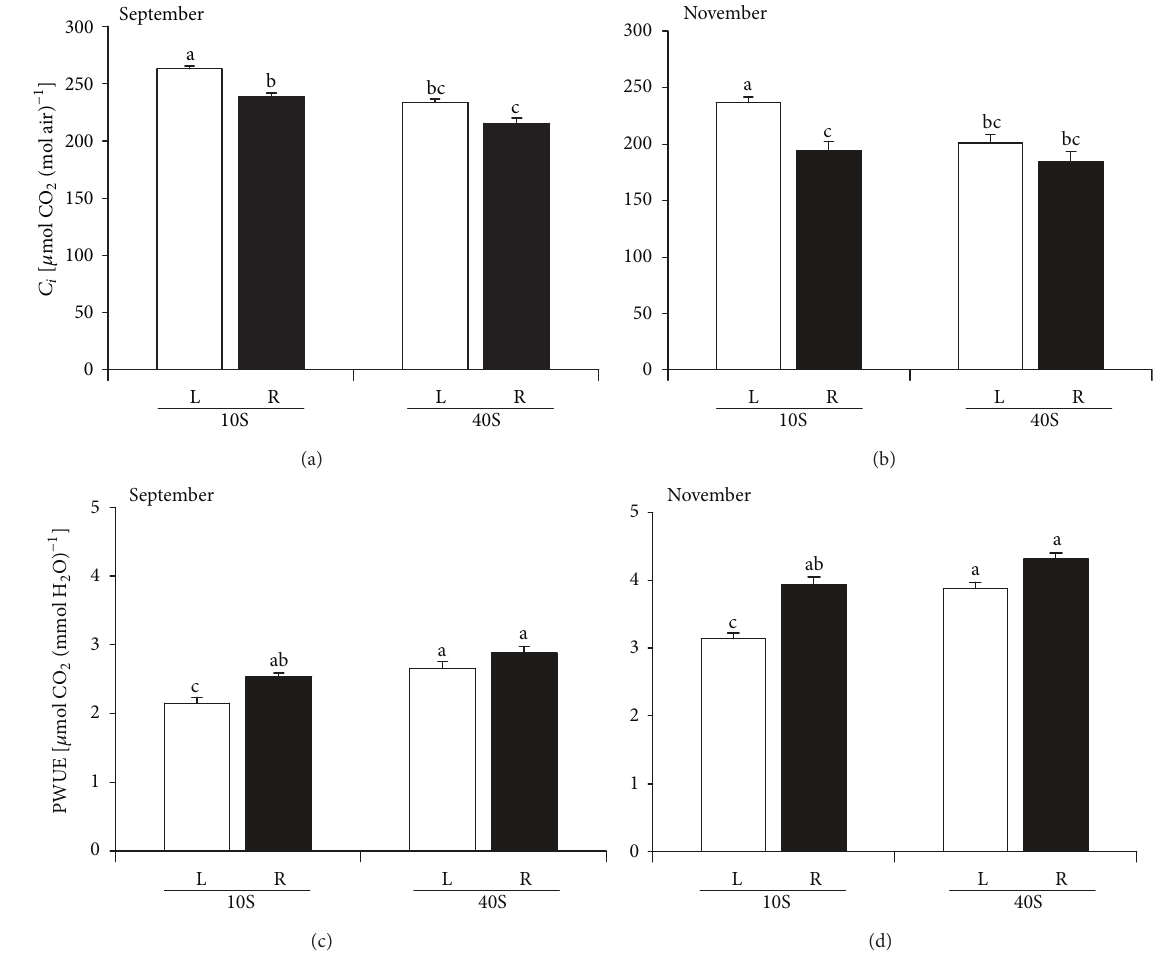
Figure 2: Leaf intercellular CO 2 concentration ( 𝐶 𝑖 ) and photosynthetic water use efficiency (PWUE) for Laguncularia racemosa (L) and Rhizophora mangle (R) in response to 10g/L (10S) or 40g/L (40S) salinity. Data are displayed according to the highest order significant interaction (Table 1). Values are means ± 1SE. Effects annotated with the same letter indicate lack of significance ( 𝑃 > 0.05 ) after Bonferroni adjustment ( 𝛼 = 0.05/12 ) for a particular graph.